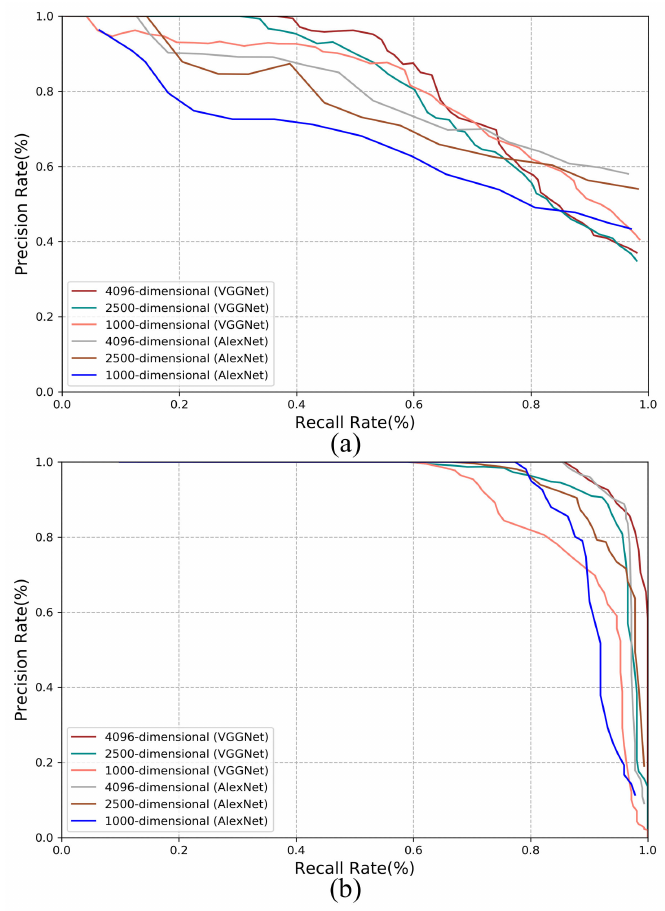
Figure 12. Performance comparison with different dimensions of feature vector ( a ) Results on the New College dataset. ( b ) Results on the TUM